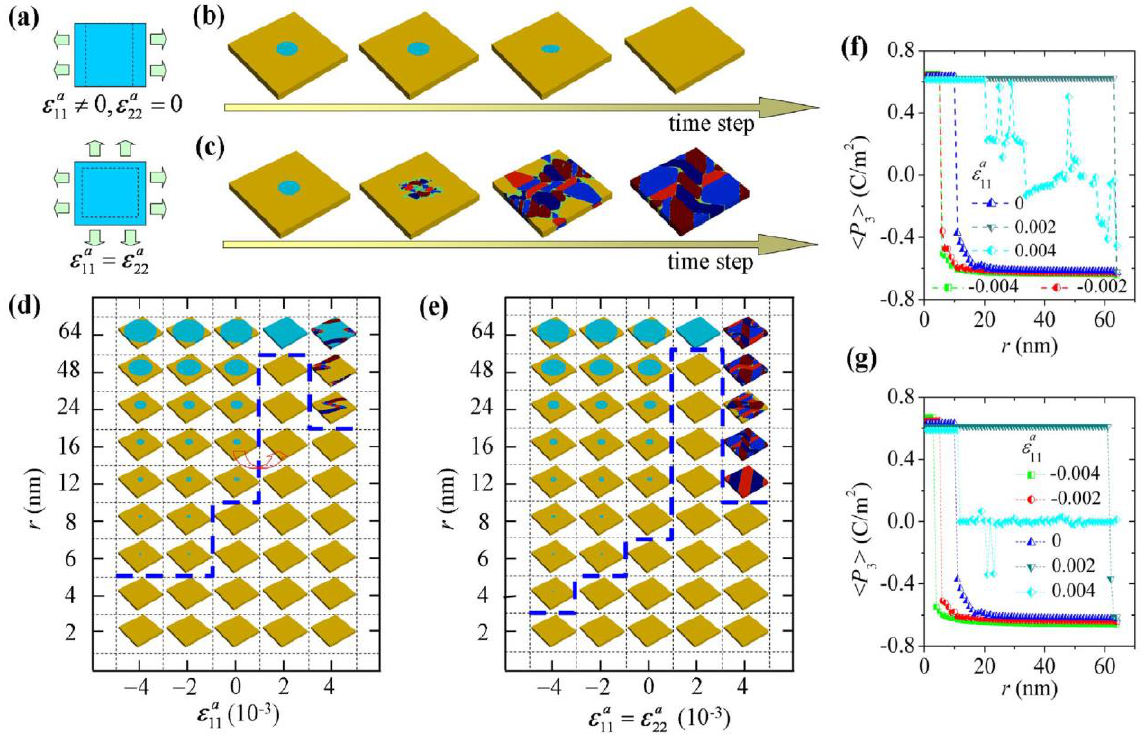
Figure 14. Control of domain stability by uniform strain on 128 nm × 128 nm × 8 nm simulation cells at room temperature. The cells are initially written with cylindrical domains with size r from 1 nm to 64 nm. ( a ) Schematics of a cell under biaxial strain and uniaxial strain. Domain evolution in a cell with cylindrical domain ( r = 16 nm) under ( b ) and ( c ) . Phase diagrams of equilibrium domain pattern in cell under ( d ) uniaxial strain and € biaxial strain. ( f ) and ( g ) the average polarization of the equilibrium domain patterns in z -direction, i.e. , < P 3 >, in the initial cylindrical domain region, for the two loading cases (Reprint with permission from